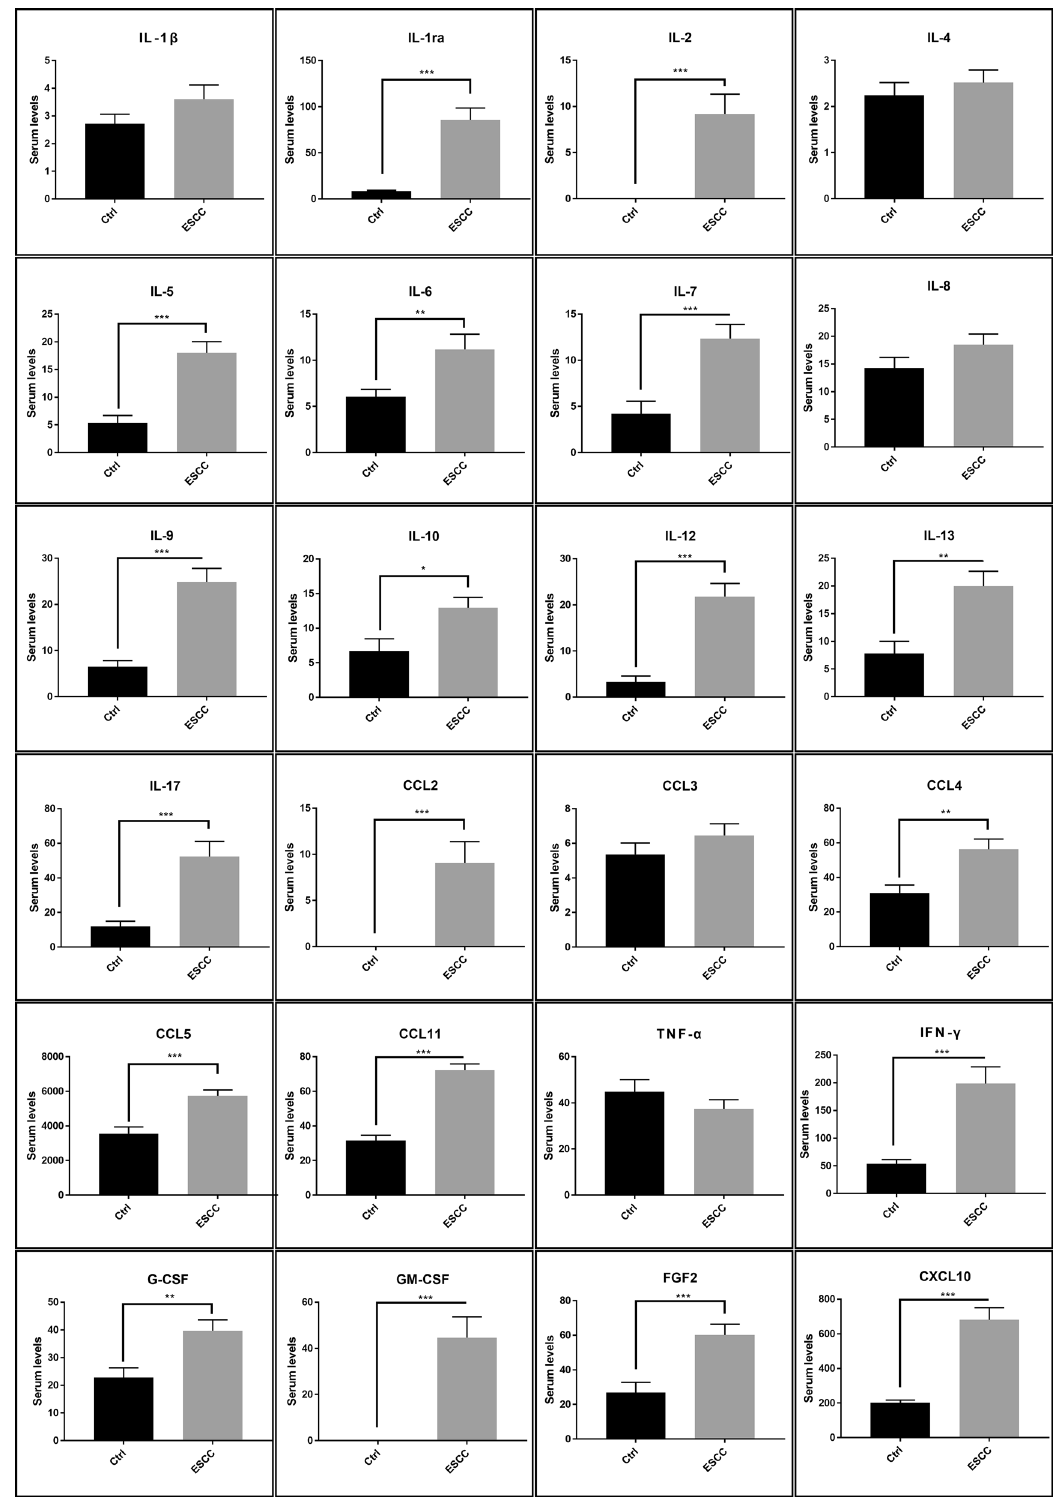
Figure 1. Comparison in systemic cytokines. Cytokines in healthy subjects and patients with oesophageal squamous cell carcinoma were compared. Bars indicate average ± SEM. *p < 0.05; **p < 0.01; ***p <